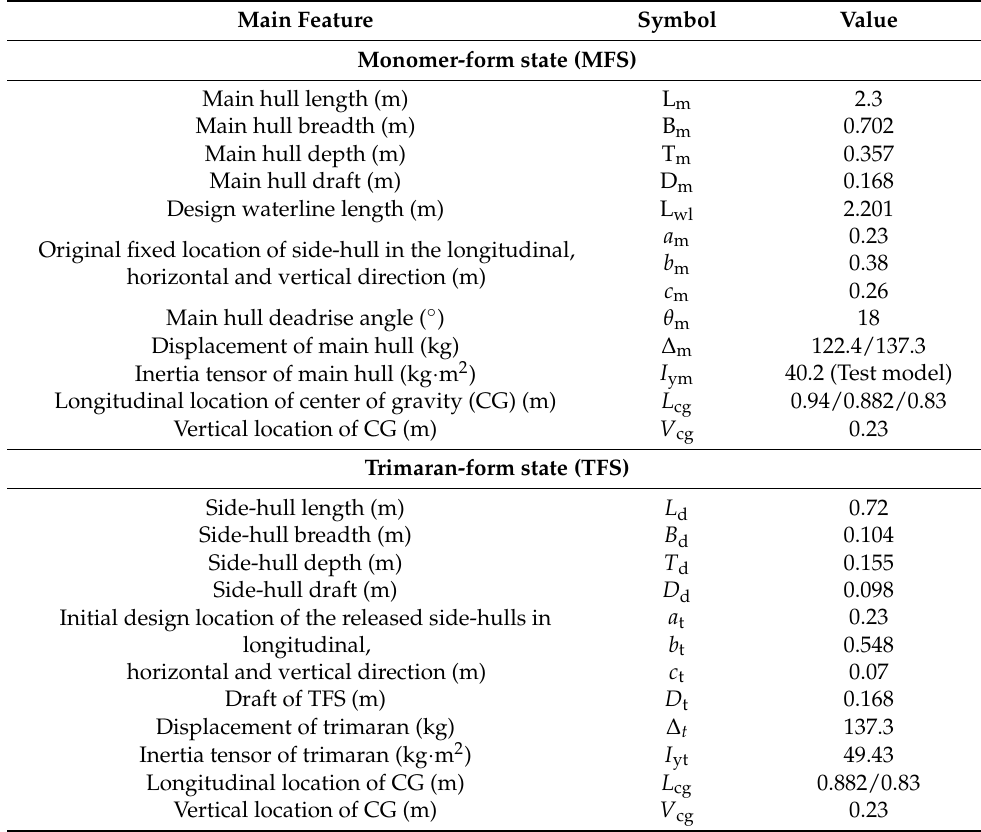
Figure 2. Molded lines of the model: ( a ) main hull; ( b ) side ‐ hull. Table 1. Primary geometric details of the planing hull at each navigation state.